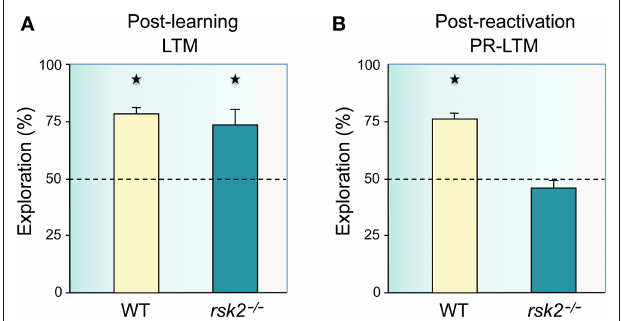
FiguRe 1 | Reconsolidation, but not consolidation of spatial, object- place recognition memory is impaired in Rsk2 mutant mice. (A) Rsk2 mutant mice showed no deficit in long-term spatial recognition memory (LTM) over 48 h as they showed preferential exploration of the displaced object ( n = 13; t = 3.53; p = 0.0041) as did wild-type (WT) mice ( n = 13; t = 9.83; p = 0.0001), with no significant difference in the amount of time spent exploring the displaced object between WT and mutant mice ( F = 0.416; 1,24 p = 0.525). (B) In contrast, 24 h after reactivation of the memory, Rsk2 mutant mice showed a deficit as they displayed no preference for the displaced object ( t = 1.43; p = 0.17) as opposed to the WT mice ( t = 14.61; p = 0.0001); and the level of exploration of the displaced object was significantly greater in WT mice compared with mutant mice ( F = 70.753; p = 0.0001). Ordinates: 1,24 percent time spent exploring the displaced object over the mean of the time spent exploring the two non-displaced objects.